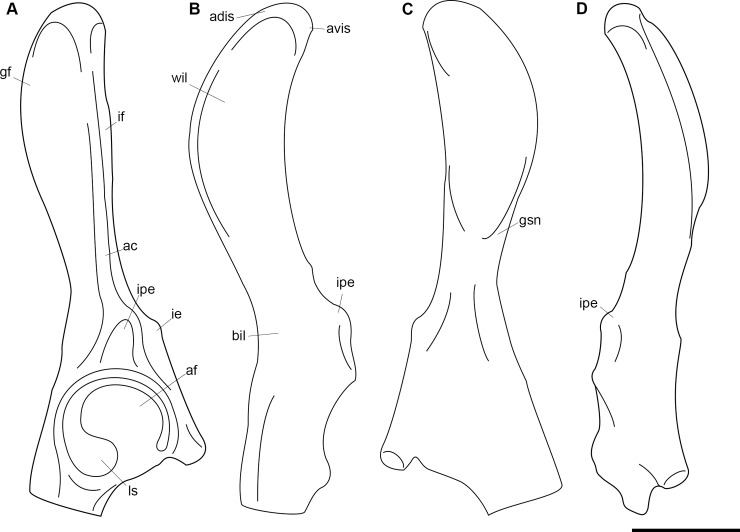
Annotated line drawing of the innominate of Periptychus carinidens.(A) lateral view; (B) dorsal view; (C) medial view; (D) ventral view. Abbreviations: ac, acetabular crest; adis, anterodorsal iliac spine; af, acetabular fossa; avis, anteroventral iliac spine; bil, body of the ilium; gf, gluteal fossa; gsn, greater ischiatic notch; if, iliacus fossa; ie, iliopubic eminence; ipe, iliopectineal eminence; ls, lunate surface; wil, wing of the ilium. Scale bar: 30mm.